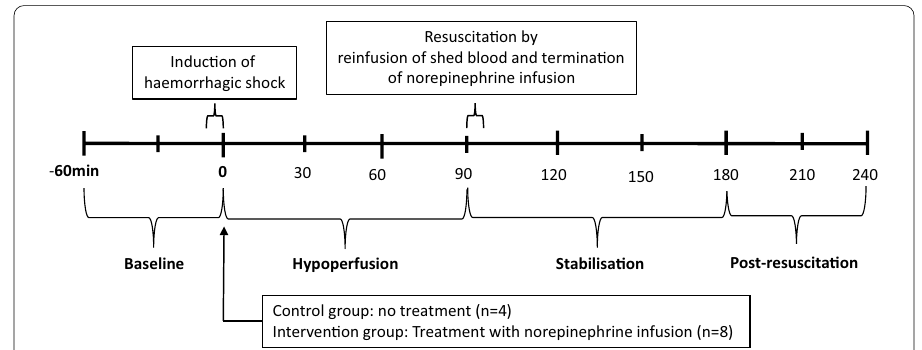
Fig. 1 Experimental protocol timeline. Note that the experimental protocol is divided into four intervals. Interval 1: Baseline 60–0 min. Interval 2: Hypoperfusion period 0–90 min, Interval 3: Stabilisation period − 90–180 min in which physiological state might return to homeostasis. Interval 4: post‑resuscitation